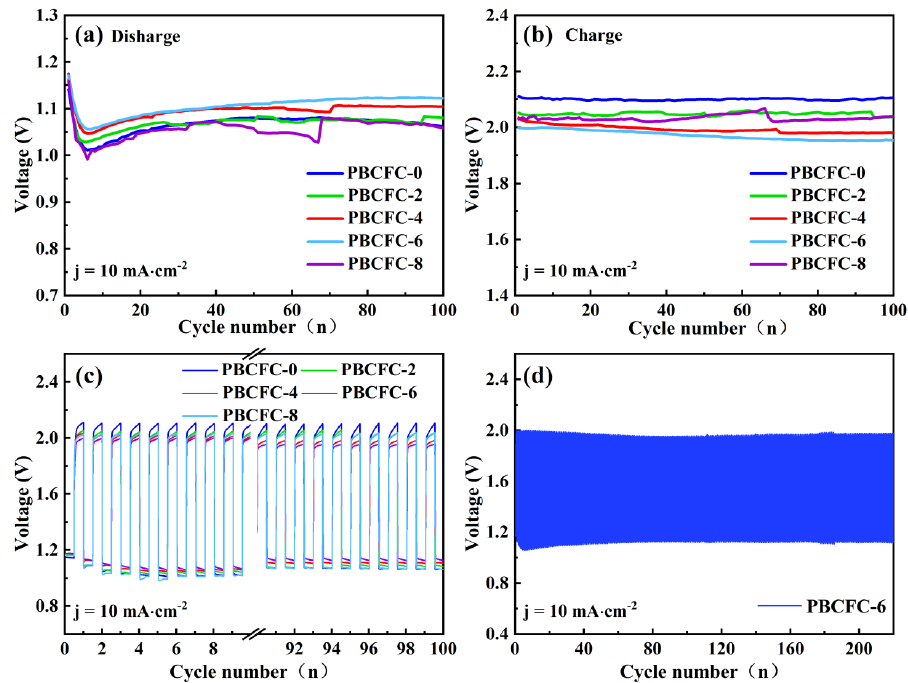
Figure 7. Constant current discharge cut-off voltage ( a ); Constant current charge cut-off voltage ( b ) of per cycle for a rechargeable zinc vacant battery with PBCFC-x as the oxygen electrode at 10 mA · cm − 2 ; Comparison of cycling curves for PBCFC-x ( c ); Cycling curves for PBCFC-6 ( d ).